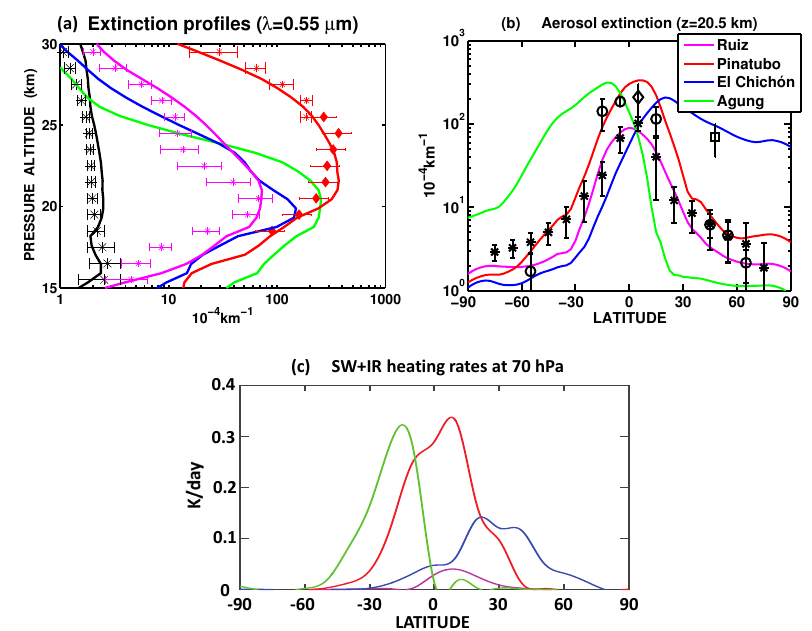
Figure 7. Top left panel ( a ) model-calculated vertical profiles of the aerosol extinction at 5 ˝ N for Pinatubo during October 1991 (red) and 5 ˝ S for Ruiz during March 1986 (magenta): cases with E shear of the equatorial winds; at 10 ˝ N for El Chichón during August 1982 (blue) and at 5 ˝ S for Agung during September 1963 (green): cases with W shear of the equatorial winds. A volcanically clean extinction profile at 5 ˝ N is shown in black, averaged over 1999–2000. SAGE-II observations are shown with asterisks and uncertainty bars: black for 1999/2000, magenta for March 1986 (Ruiz), red for October 1991 (Pinatubo). Pinatubo observations are from SAGE-II observations only above 25 km altitude (since the instrument was saturated below this altitude); lidar observations (red diamonds) are used below 25 km [32]. The clear difference in aerosol extinction above approximately 24 km can be seen between Agung and El Chichón on one side (QBO W shear) and Pinatubo and Nevado del Ruiz on the other side (QBO E shear). Top right panel ( b ) zonal-mean latitudinal section of the model-calculated aerosol extinction at 20.5 km altitude, compared with SAGE-II data: black asterisks for March 1986 (Ruiz), black circles for October 1991 (Pinatubo) (at 25.5 km in the tropics). The black diamond is derived from lidar measurements of Grant et al. [32] for October 1991 (Pinatubo) at 20.5 km; the black square is from lidar measurements of Jäger and Hofmann [60] for August 1982 (El Chichón). Bottom panel ( c ) zonal-mean latitudinal section of the model-calculated aerosol heating-rate changes VE-REF at 70 hPa (K/day) for the aerosol distribution four months after each eruption, as in panels ( a ) and ( b ) (instantaneous SW + IR heating-rate changes, with fixed temperature and ozone